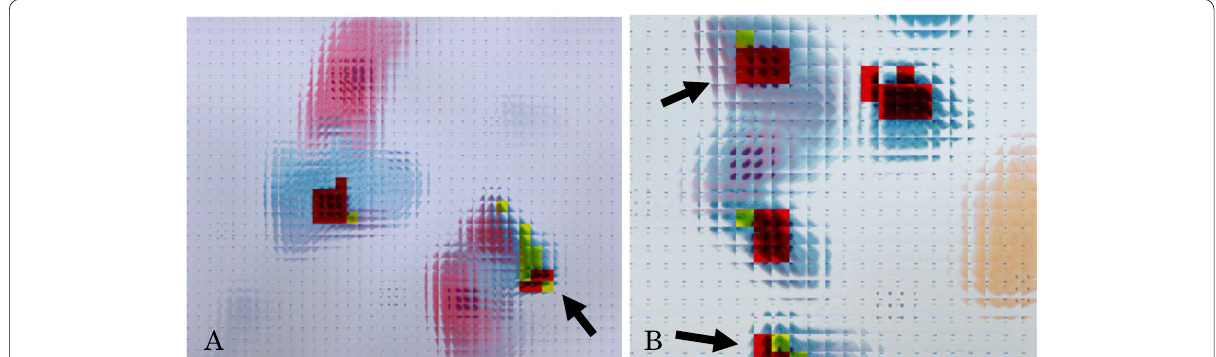
Fig. 3 Example of images in which the convolutional neural network was identified as the cell nuclei. Red indicates > 90% probability of being a cell nucleus, while yellow indicates > 50% probability of being a cell nucleus. A An example of detection from background (arrow). B An example where a nucleus was not detected